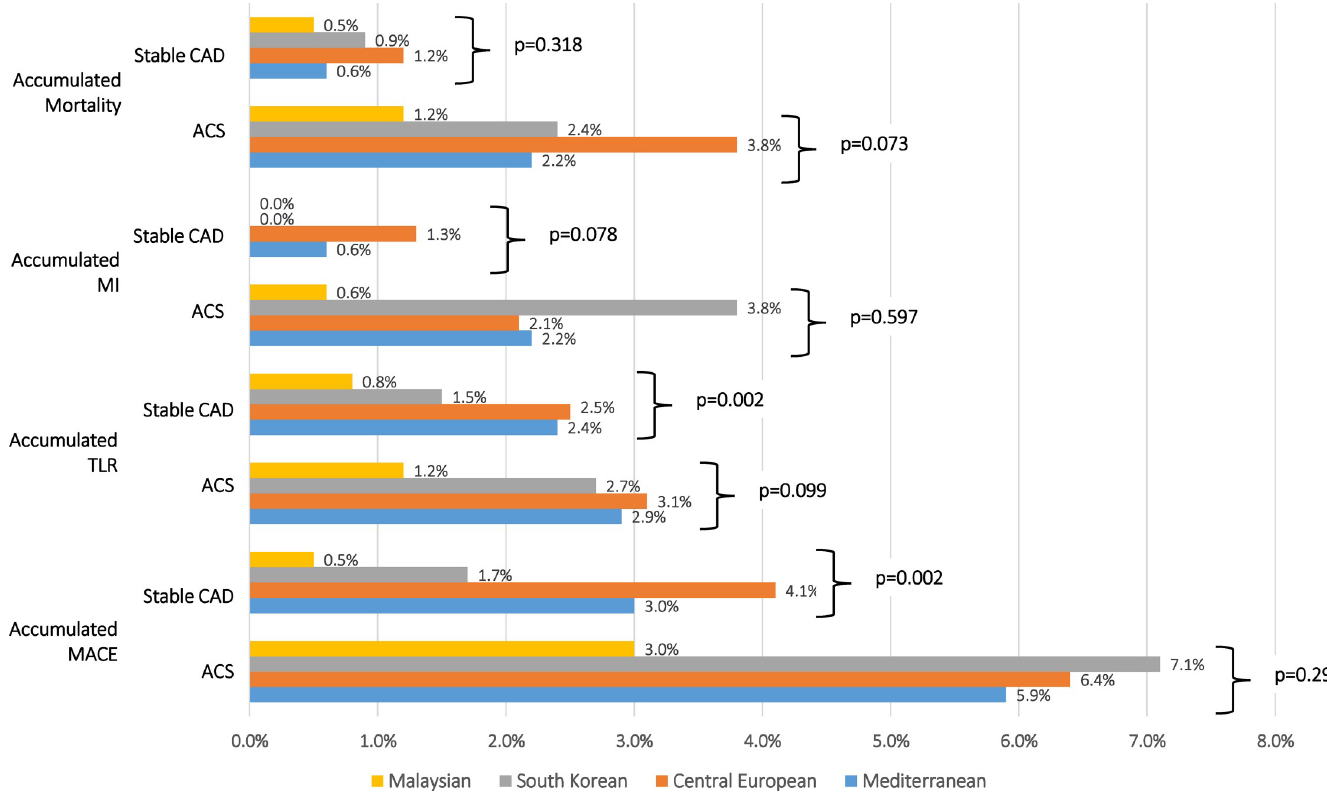
Fig 2. Clinical outcomes in stable CAD and ACS patients per defined region.